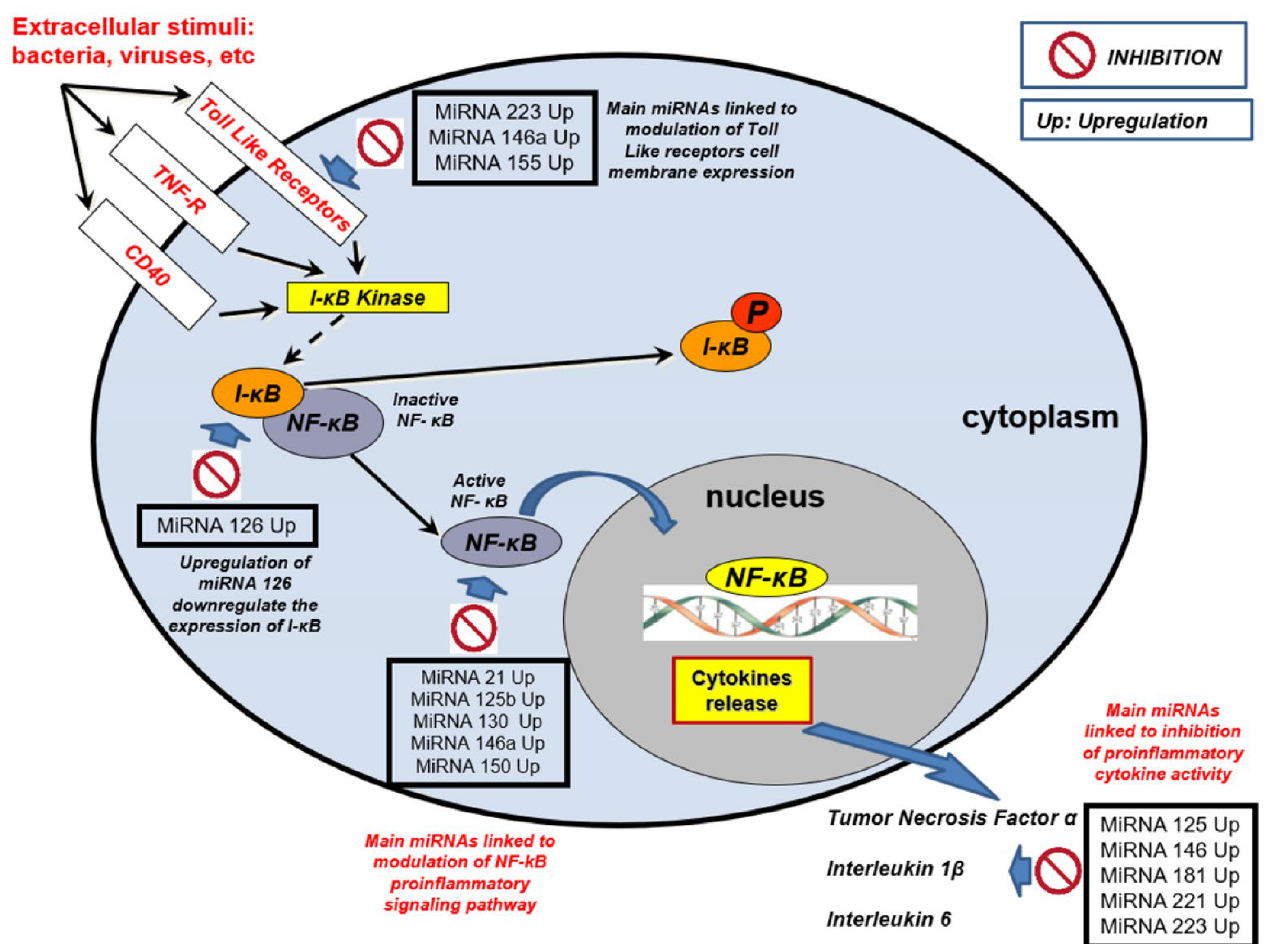
Figure 1. MicroRNAs (miRNAs) in sepsis. Regulatory mechanisms of the pro-inflammatory state and interaction with host defense mechanisms that may substantiate their role as biomarkers.